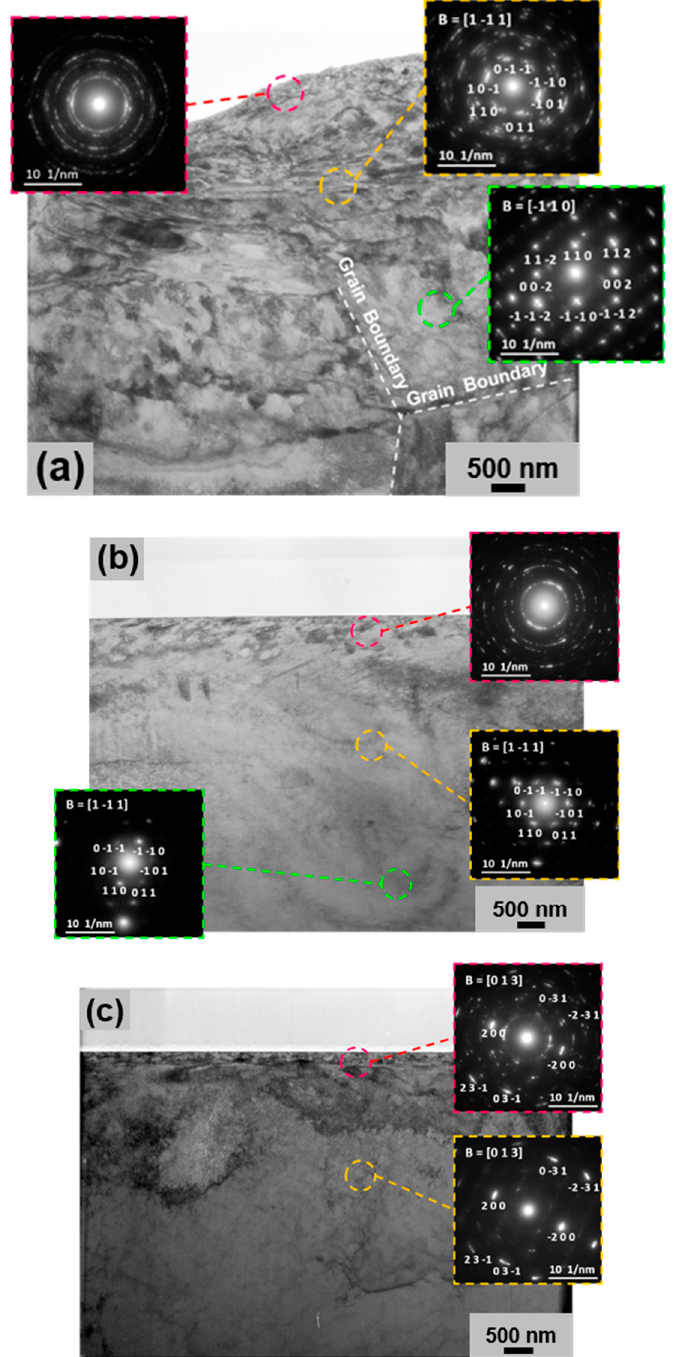
Figure 2. TEM observations of 304L cross-section, after, ( a ) grinding process, ( b ) polished samples down to 2400 with SiC, ( c ) polished samples down to 1 µm with diamond paste, in window capture present electron diffraction patterns as a function of the surface depth.